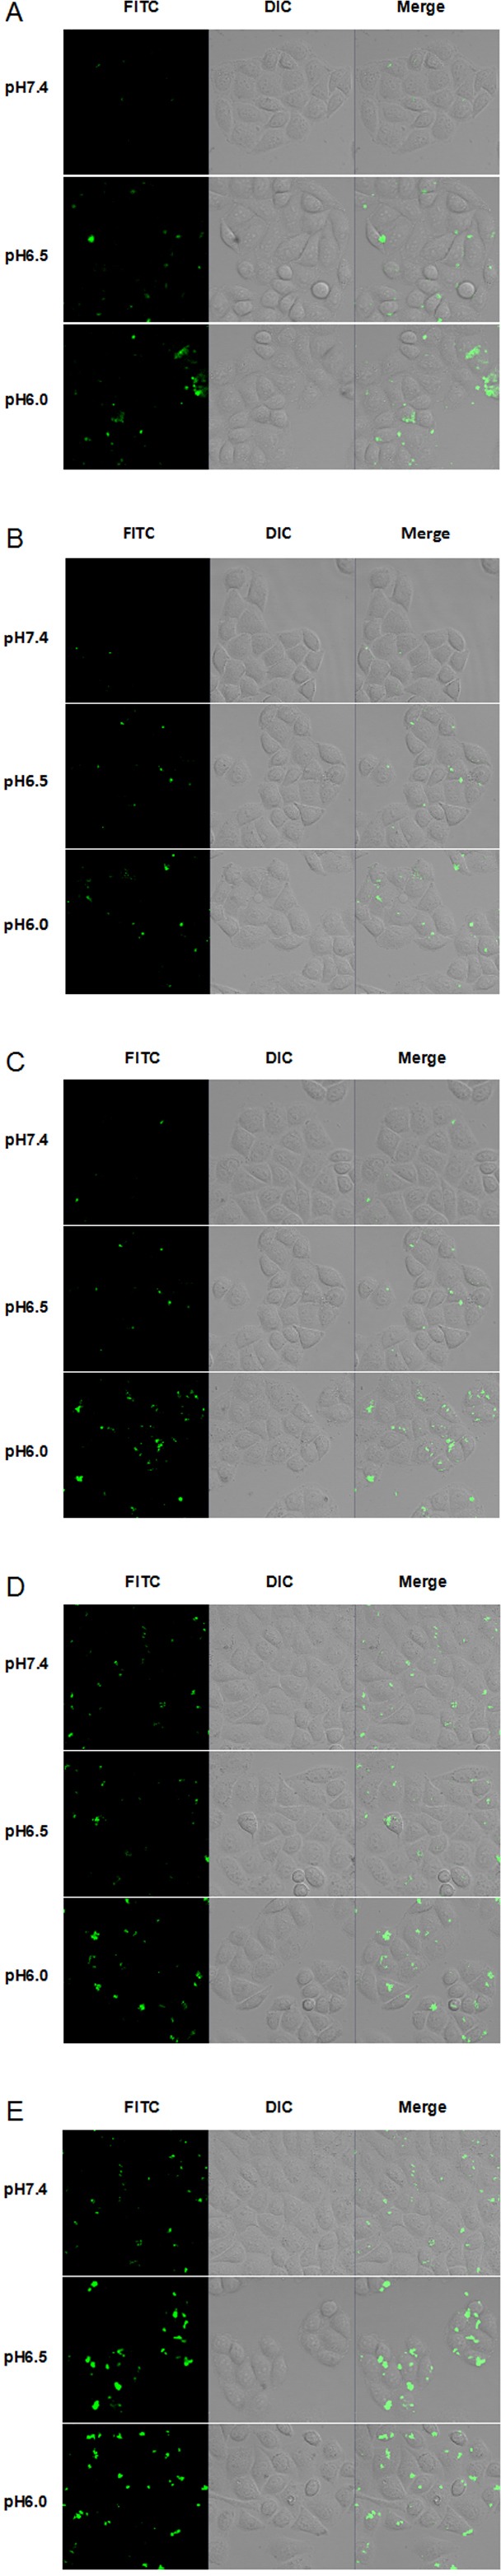
CLSM images of Hela cells incubated with 5 µM FITC labeled TH analogs at different pH conditions (pH7.4, pH6.5 and pH6.0) for 1 h.(A) FITC-TH. (B) FITC-Methyl-TH. (C) FITC-Ethyl-TH. (D) FITC-Isopropyl-TH. (E) FITC-Butyl-TH.